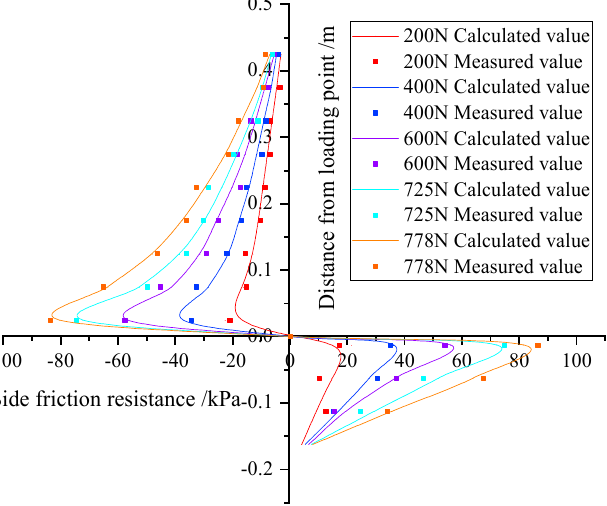
Figure 11. Distribution of test pile body side friction resistance under different levels of loading.